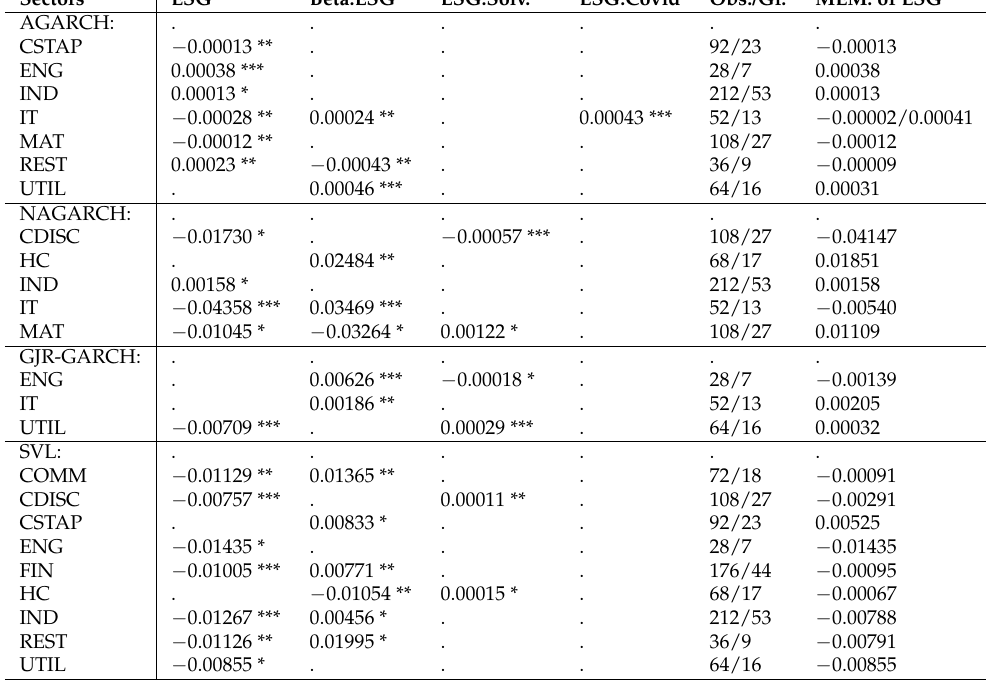
Table 7. AB-GLS results, by sector.